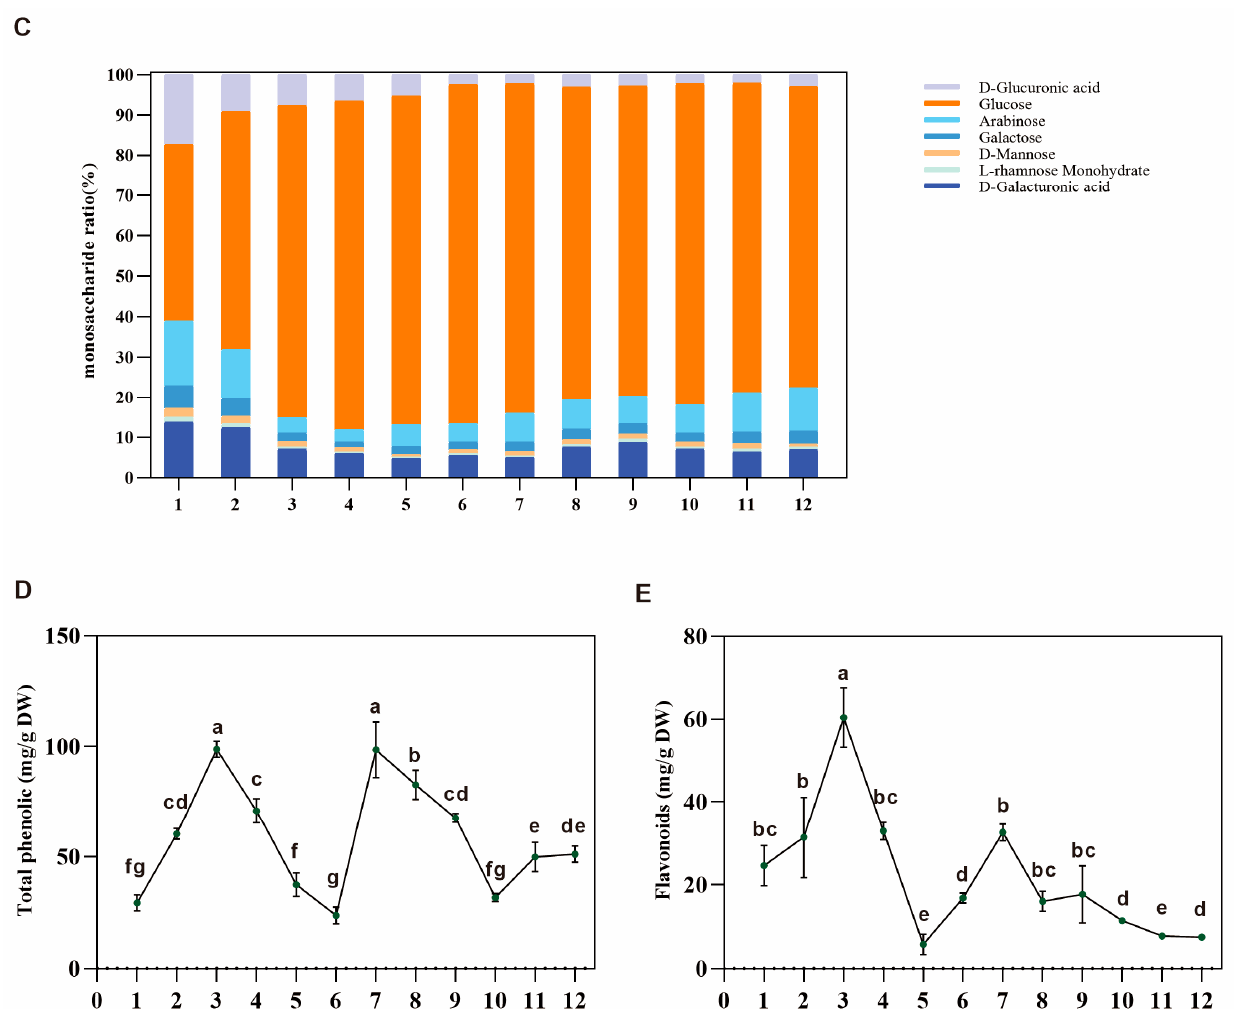
Figure 2. Crude polysaccharide, soluble protein, total phenolic acid and flavonoid contents, and the ratio of seven monosaccharides in the root of Codonopsis pilosula at different growth stages. ( A ) Dynamic changes in crude polysaccharide content during these periods. ( B ) Dynamic changes in soluble protein content during these periods. ( C ) The ratio of seven monosaccharides in the crude polysaccharides of Dangshen. ( D ) Dynamic changes in total phenolic acid content during these periods. ( E ) Dynamic changes in flavonoid content during these periods. DW: dry weight. Values represent means ± SE (n ≥ 3). Different letters above the bars indicate a significant difference ( p < 0.05) by one-way ANOVA with Tukey’s multiple comparisons test.